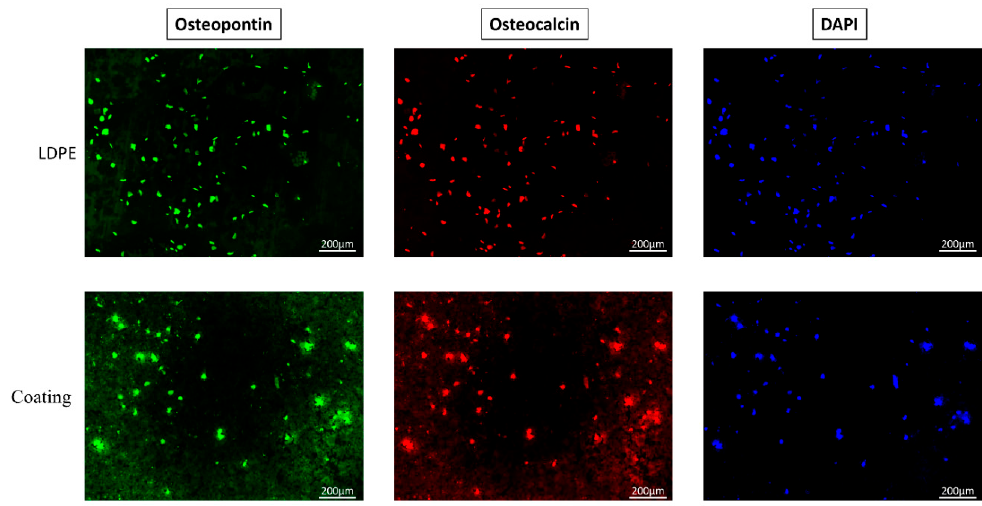
Figure 8. LDPE fluorescence micrograph samples after exposure to SaOS-2 cells. Green and red stains identify osteocalcin and osteopontin, respectively, while blue shows cell nuclei.